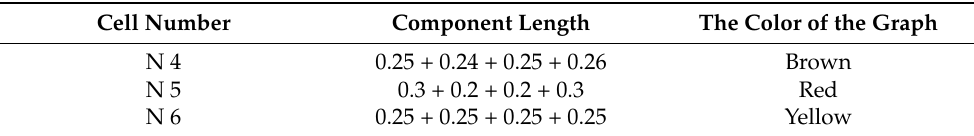
Table 2. Small perturbations of a monodisperse crystal with a period 2 times smaller. Description of the unit cell [0,1].